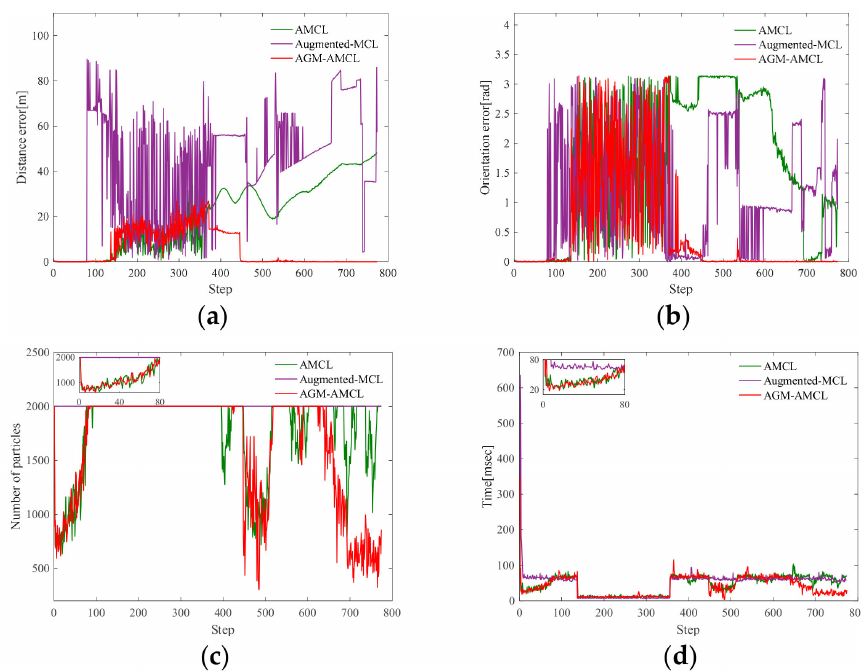
Figure 14. Localization results in scene B: ( a ) distance error; ( b ) orientation error; ( c ) number of particles; ( d ) running time. From step 700 to 800, our method is more e ffi cient because of the right convergence. The zoomed results from step 0 to 80 show that our localization method has similar running time with AMCL in unambiguous area.